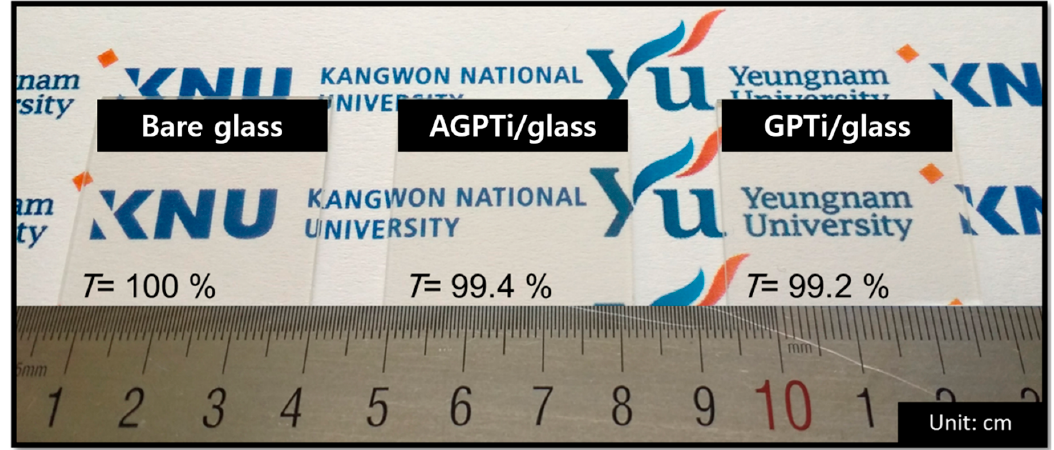
Figure 2. Images of the bare glass and AGPTi- and GPTi-coated glasses used for the fabrication of highly transparent electrodes.